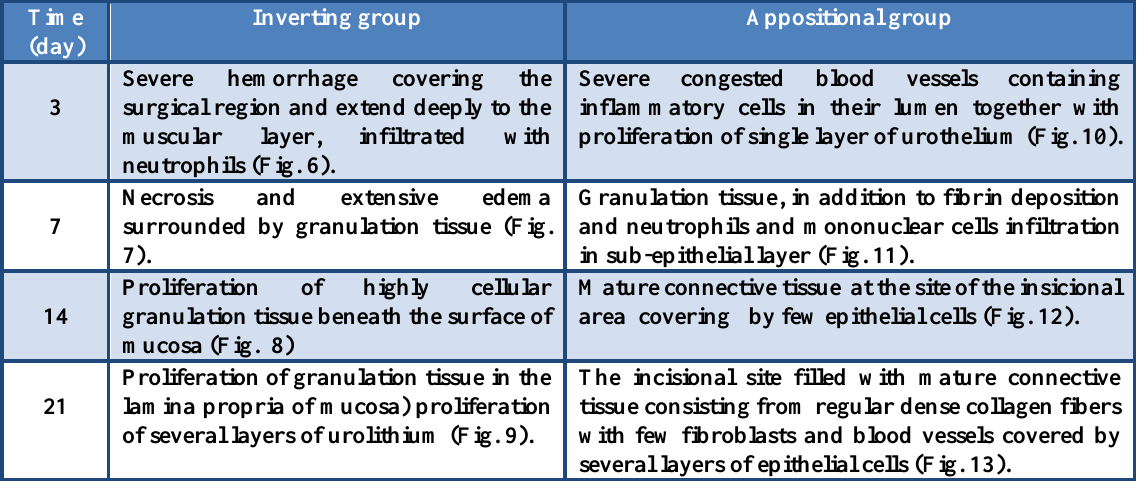
Table, 2: The results of histopathological sections of bladder related to both groups. Time Inverting group Appositional group (day) Severe hemorrhage covering the Severe congested blood vessels containing 3 surgical region and extend deeply to the inflammatory cells in their lumen together with muscular layer, infiltrated with proliferation of single layer of urothelium (Fig. 10). neutrophils (Fig. 6). Necrosis and extensive edema Granulation tissue, in addition to fibrin deposition 7 surrounded by granulation tissue (Fig. and neutrophils and mononuclear cells infiltration 7). in sub-epithelial layer (Fig. 11). Proliferation of highly cellular Mature connective tissue at the site of the insicional 14 granulation tissue beneath the surface of area covering by few epithelial cells (Fig. 12). mucosa (Fig. 8) Proliferation of granulation tissue in the The incisional site filled with mature connective 21 lamina propria of mucosa) proliferation tissue consisting from regular dense collagen fibers of several layers of urolithium (Fig. 9). with few fibroblasts and blood vessels covered by several layers of epithelial cells (Fig.